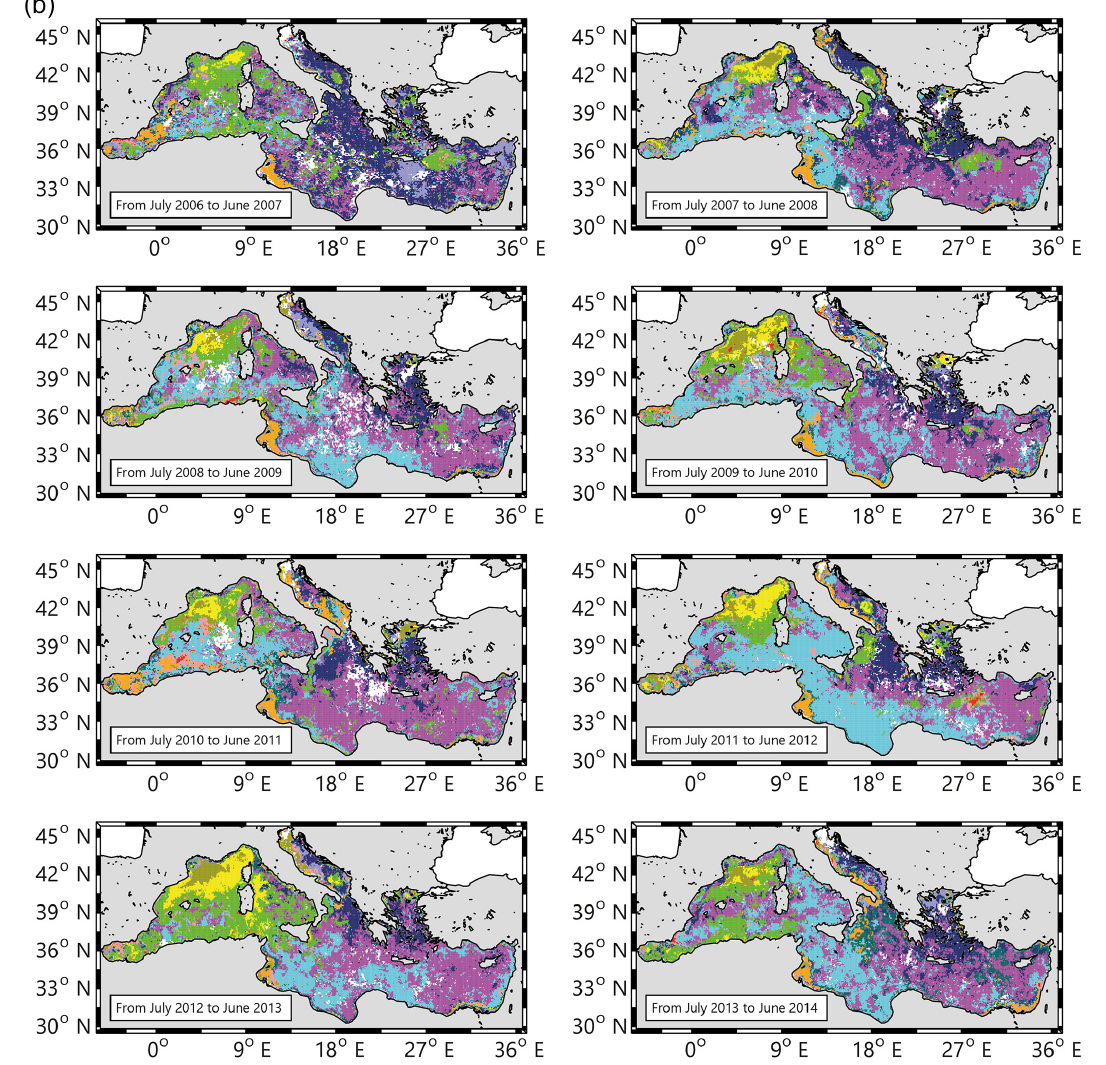
Figure 3. Maps of the spatial distribution of the trophic regimes (i.e., bioregions), (a) for the years 1999 to 2006 and (b) for the years 2007 to 2014. Note that the year is defined from July to June, (example for the map 1999, it corresponds to the period from July 1998 to June 1999). The white pixels indicate “no